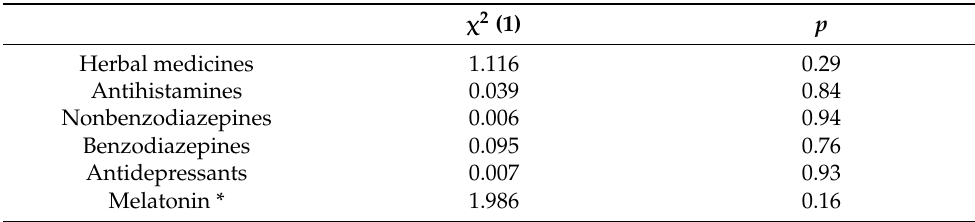
Figure 3. Previously tested sleep-inducing drugs/techniques. Table 2. Correlation between gender and previously tested sleep-inducing drugs. Results of the chi- square tests with a significance level of 0.05. are displayed in Table 2.